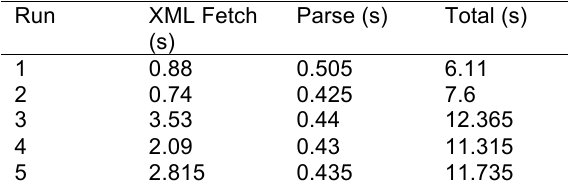
Table 4. The XML fetch and parse times in seconds over 5 runs for the data processing Android test application along with the total